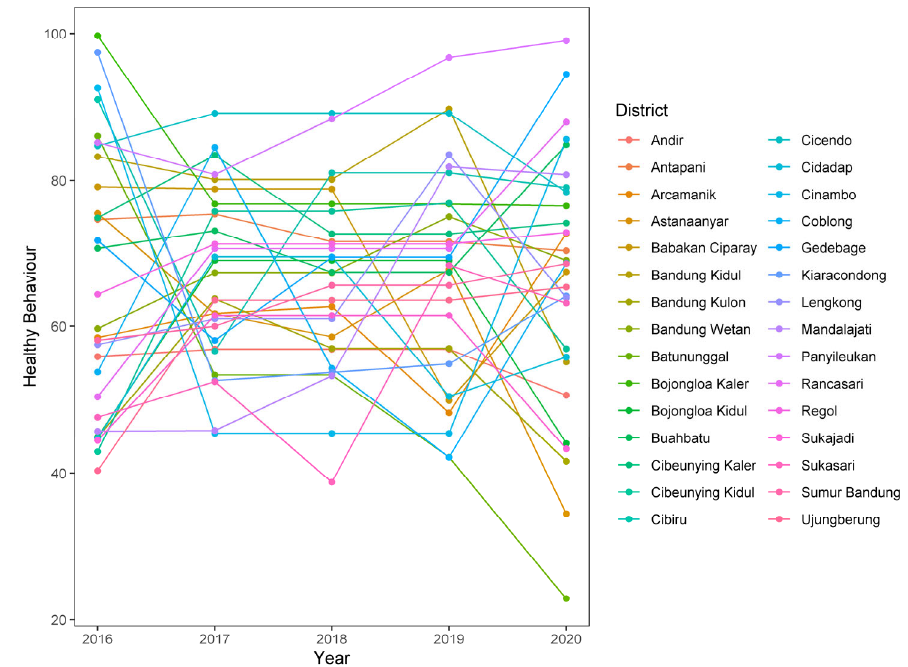
Fig. 4. Temporal trend of the healthy behavior index between 2016-2020